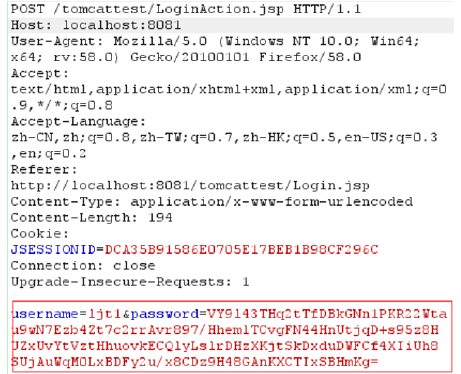
Figure 36. Constructed request message.